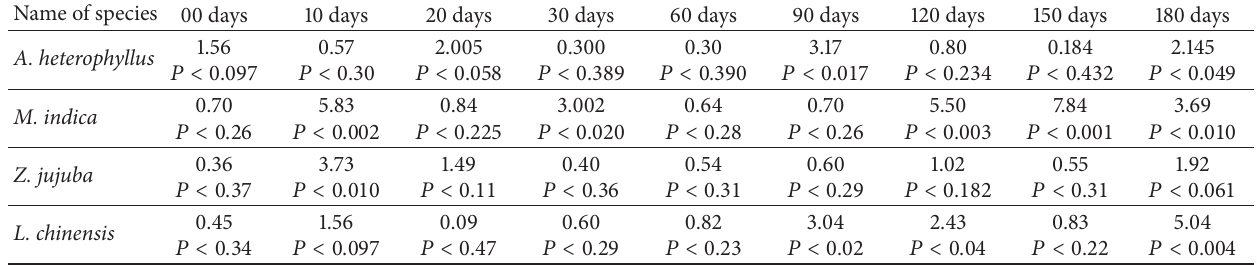
Table 5: Significant test of P concentration of leaf litter of the selected cropland agroforest horticultural tree species among dry and wet